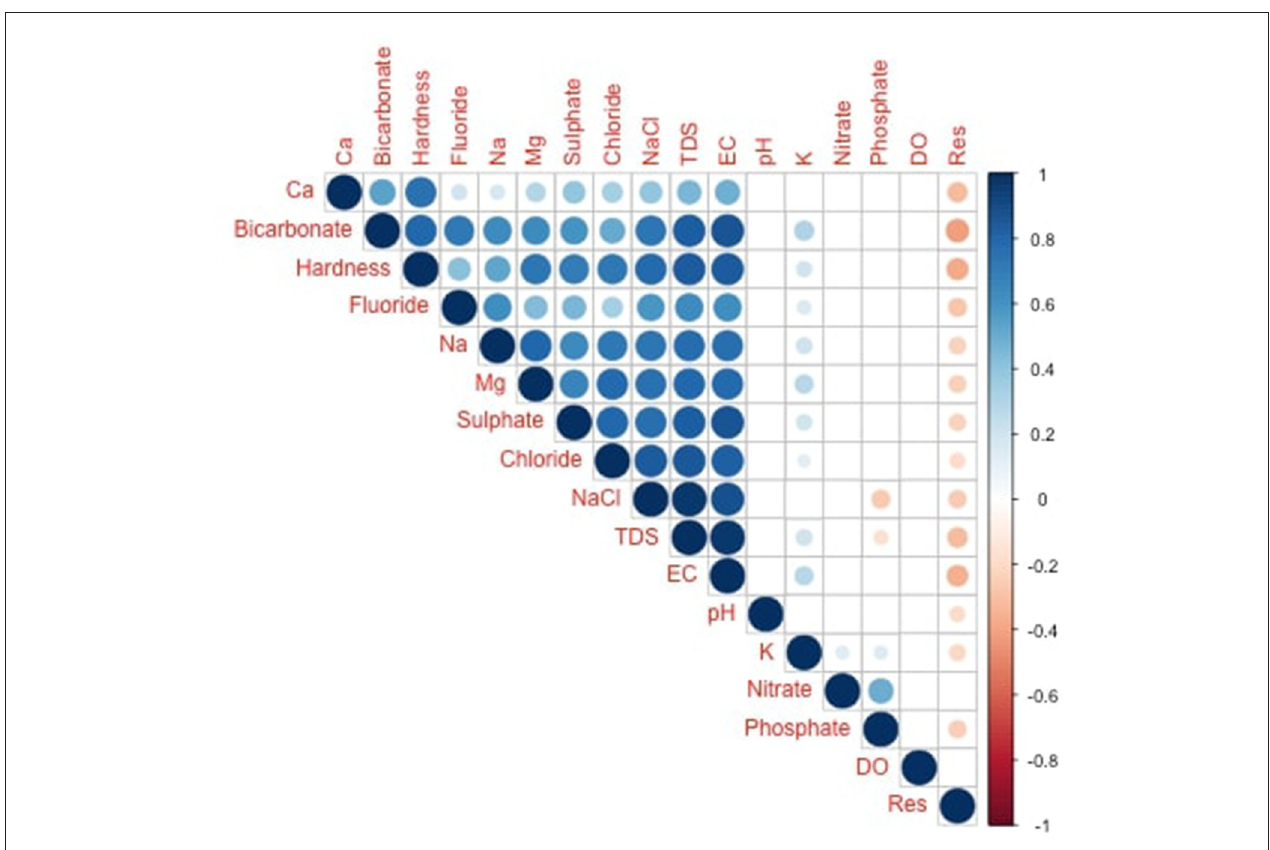
FIGURE 3 | Correlation coefficient matrix of the groundwater quality